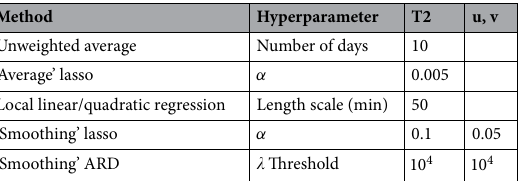
Table 3. Values and types of the hyperparameters for the different estimation methods